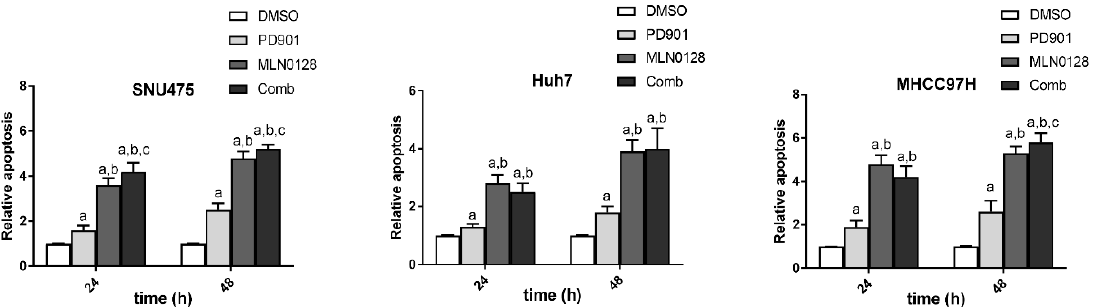
Figure 6. Effect of MLN0128/PD901 combination on apoptosis of HCC cell lines. Enhanced apoptosis in SNU475, Huh7, and MHCC97H cell lines was detected following treatment with either PD901 or MLN0128 when compared to solvent (DMSO). Apoptosis was significantly more pronounced in MLN0128- than PD901-treated cells. No consistent further increase of apoptosis than that observed in PD901- or MLN0128-treated cells was detected when the two drugs were administered in combination. Each bar represents mean ± SD of three independent experiments conducted in triplicate. Tukey-Kramer’s test: p at least < 0.005; a, vs. DMSO; b, vs. PD901; c, vs. MLN0128; d, vs. Combination. Abbreviation: Comb, combined PD901/MLN0128 treatment.